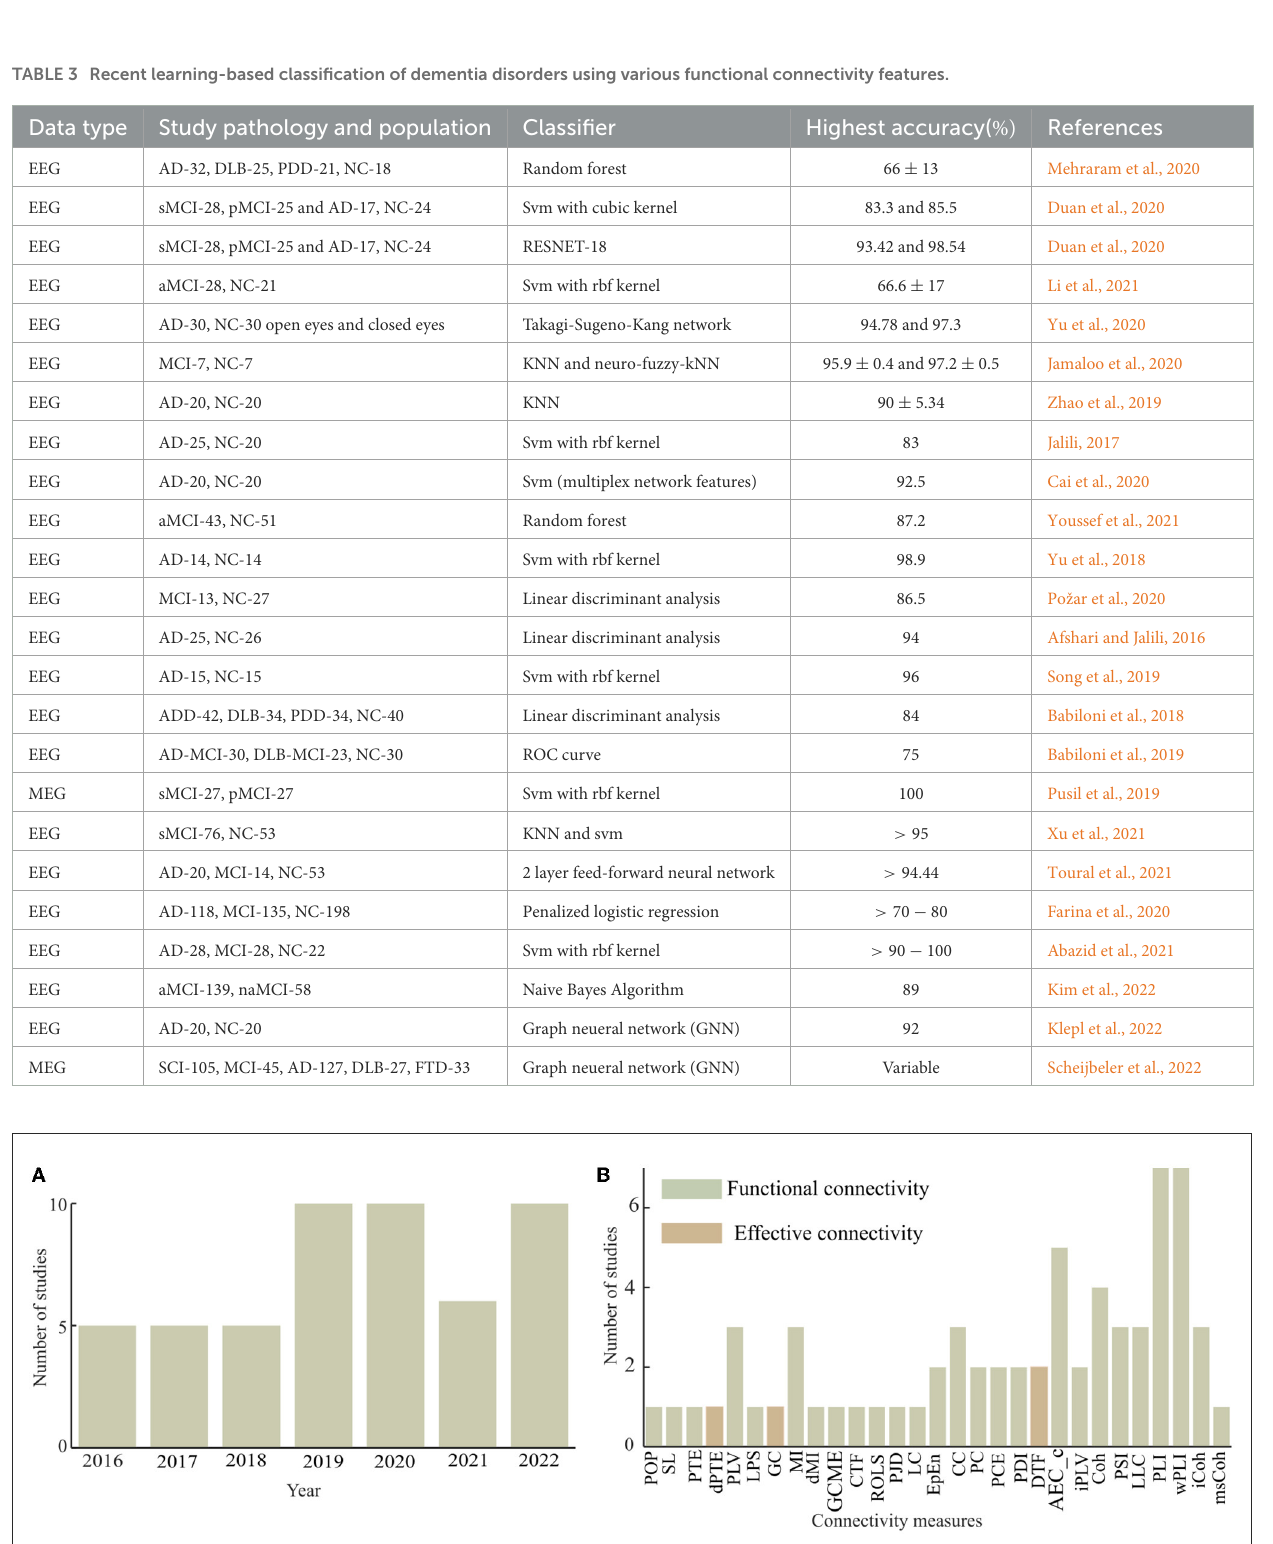
connectivity measures. The effective connectivity measures considered include phase transfer entropy (PTE), normalized phase transfer entropy (dPTE), granger causality (GC), and directed transfer function (DTF). The remaining studies either